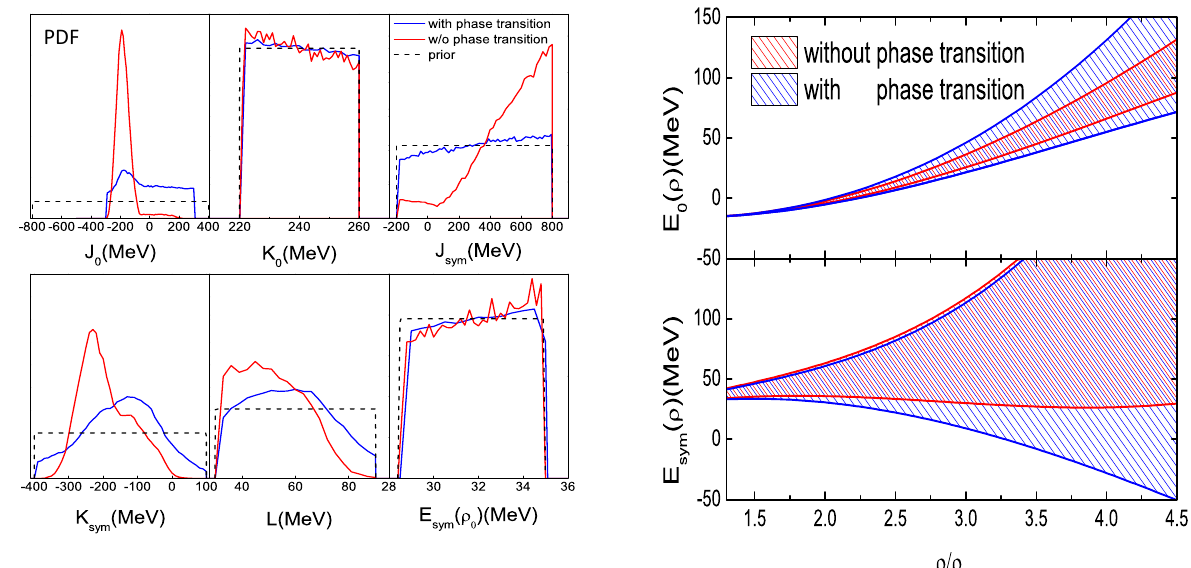
Figure 15. ( Left ) The posterior probability distribution functions (in arbitrary units) of nuclear matter EOS parameters inferred from Bayesian analyses with (thick blue curves) and without (thin red curves) considering the hadron–quark phase transition in neutron stars in comparison with their uniform priors (dashed curves). ( Right ) The corresponding 68% confidence boundaries of SNM EOS ( top ) and symmetry energy ( bottom ). Taken from